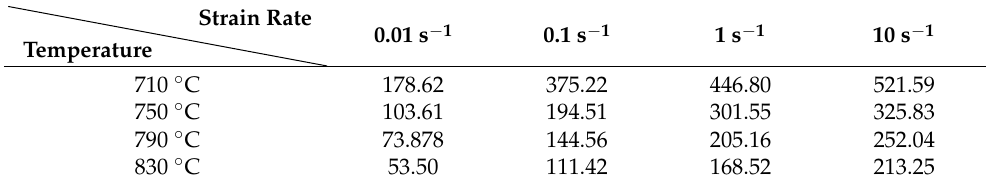
Table 1. Peak flow stress of as-quenched Ti15Zr5Cu alloy under different deformation conditions. Strain Temperature